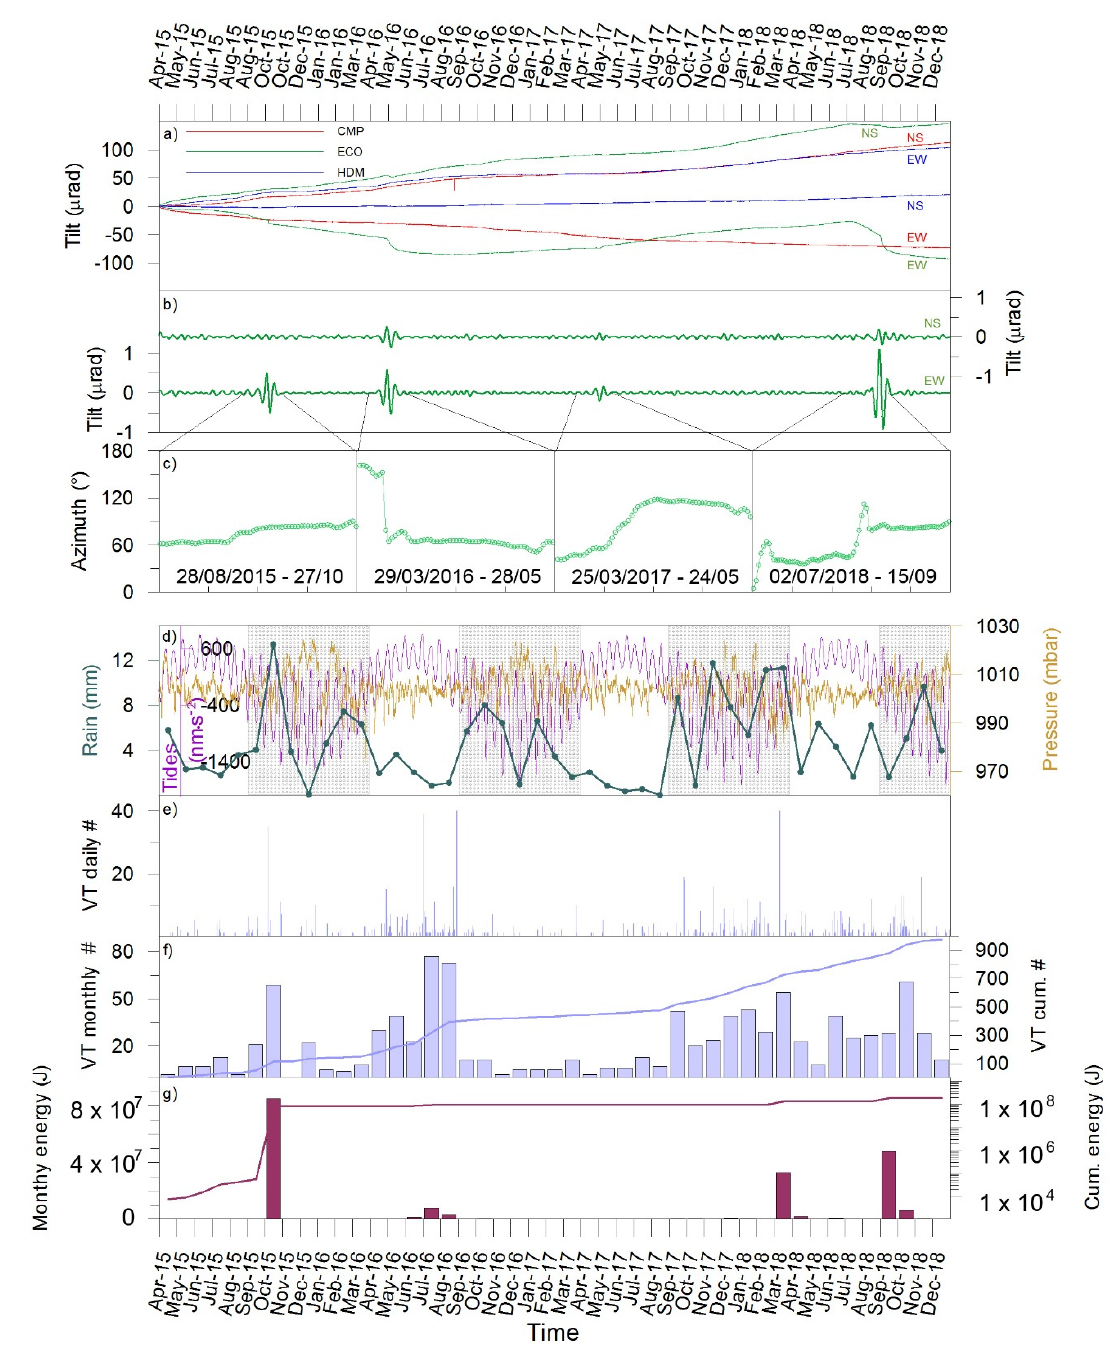
Figure 8. ( a ) Tilt time series from 1 April 2015 to 31 December 2018 for CMO, ECO and HDM (NS and EW components). The four vertical grey lines mark the maximum amplitude peak of the LAOs; ( b ) ECO tilt time series (NS and EW components) filtered in the period band corresponding to the Mf constituent; ( c ) temporal pattern of the azimuth of the LAOs over a two-month-long time window (start and end time indicated in the label); ( d ) solid Earth tides, atmospheric pressure and rainfall time series. The light-grey boxes in the background mark the wet season of the hydrological year [43]; ( e ) daily number of VTs; ( f ) monthly (bar plot) and cumulative (continuous line) number of VTs; ( g ) monthly (bar plot) and cumulative (continuous line) energy release of VTs.